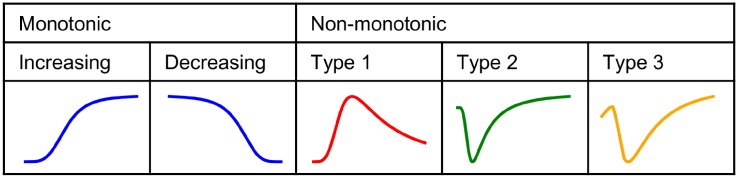
Classification of (non-)monotonic curves.